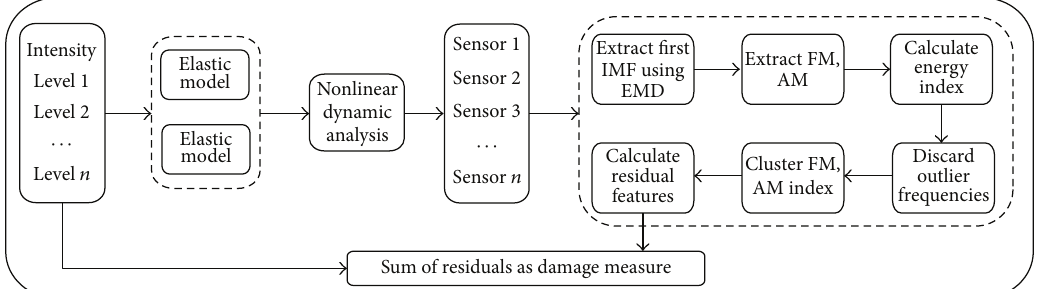
Figure 9: Overview of the algorithm.